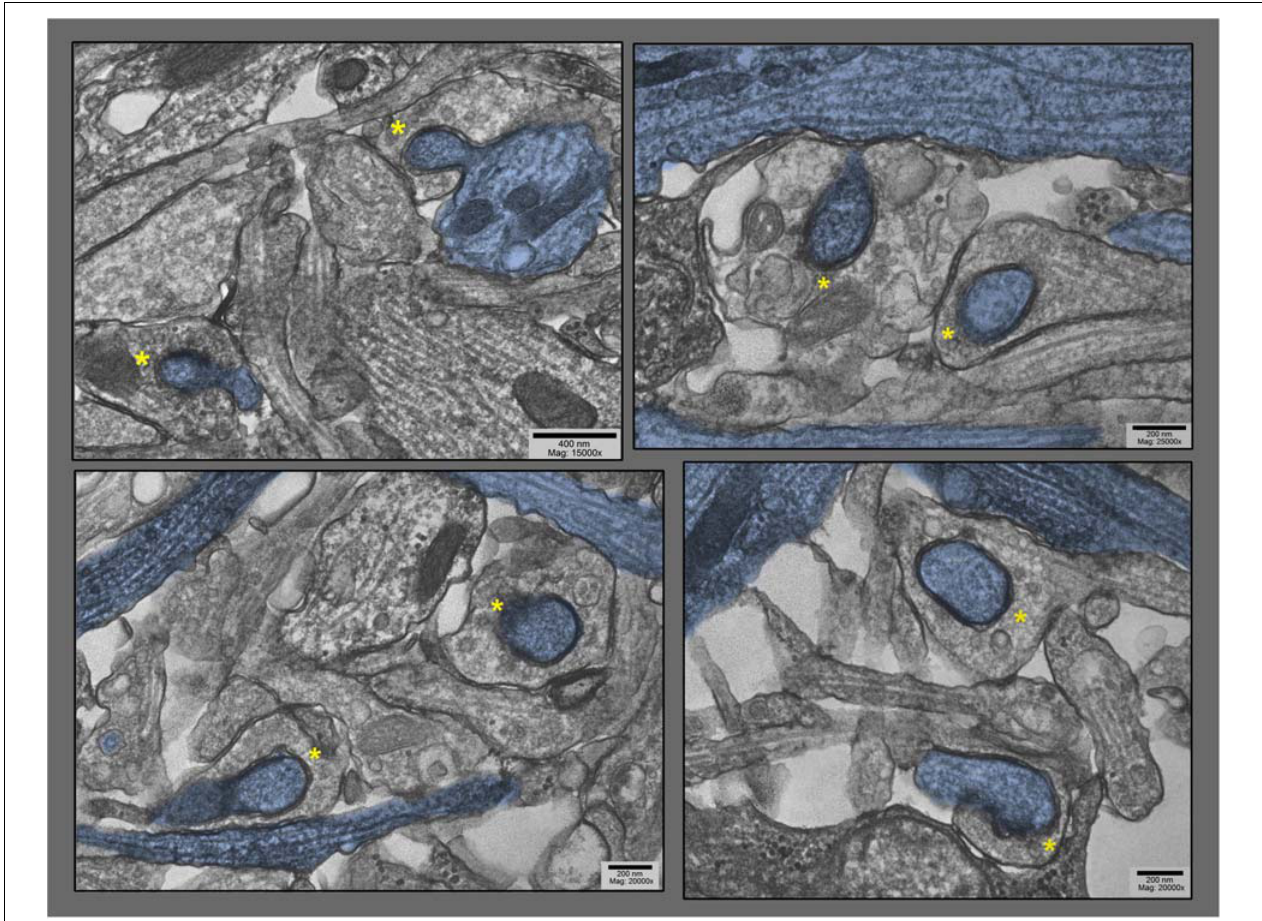
FIGURE 5 | Lower magnification survey views of hippocampal cultures exposed to 0.1 mM La + + + for 10–20 min at 37 ◦ C), where only the particular dendrites that are involuting into their apposed synapses are highlighted in blue (other dendrites are also present in these fields). These views were chosen specifically to demonstrate the old adage that George Palade, the great “founder” of biological electron microscopy, always stressed: namely, that if a structural feature could be found two or more times in one and the same field of view in the electron microscope, then it must be generally present, and must be not an artifact. Two postsynaptic “protrusions” are indicated by asterisks in each